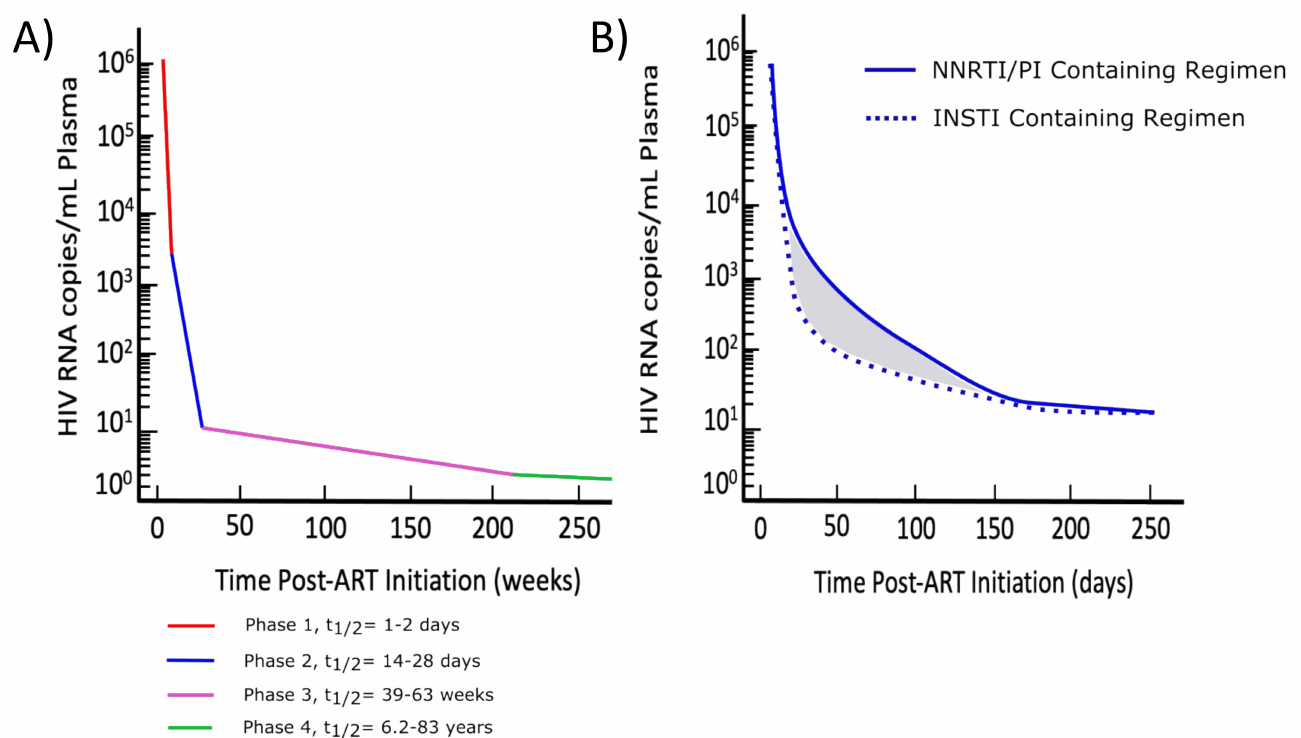
Figure 2. ( A ) Multiphasic model of viral decay. The four phases of HIV RNA decay after starting ART are shown. ( B ) Phase 1 viral load decay is greater in INSTI-containing regimens. The greater rate of phase 1 decay is likely due to the existence of two distinct populations of HIV-infected cells, some that integrate DNA slowly, and others that integrate more quickly. HIV RNA rapidly declines as INSTIs prevent integration in faster-integrating cell populations. This trend may also be explained by the later stage in the HIV lifecycle at which integrase inhibitors act. (Adapted from